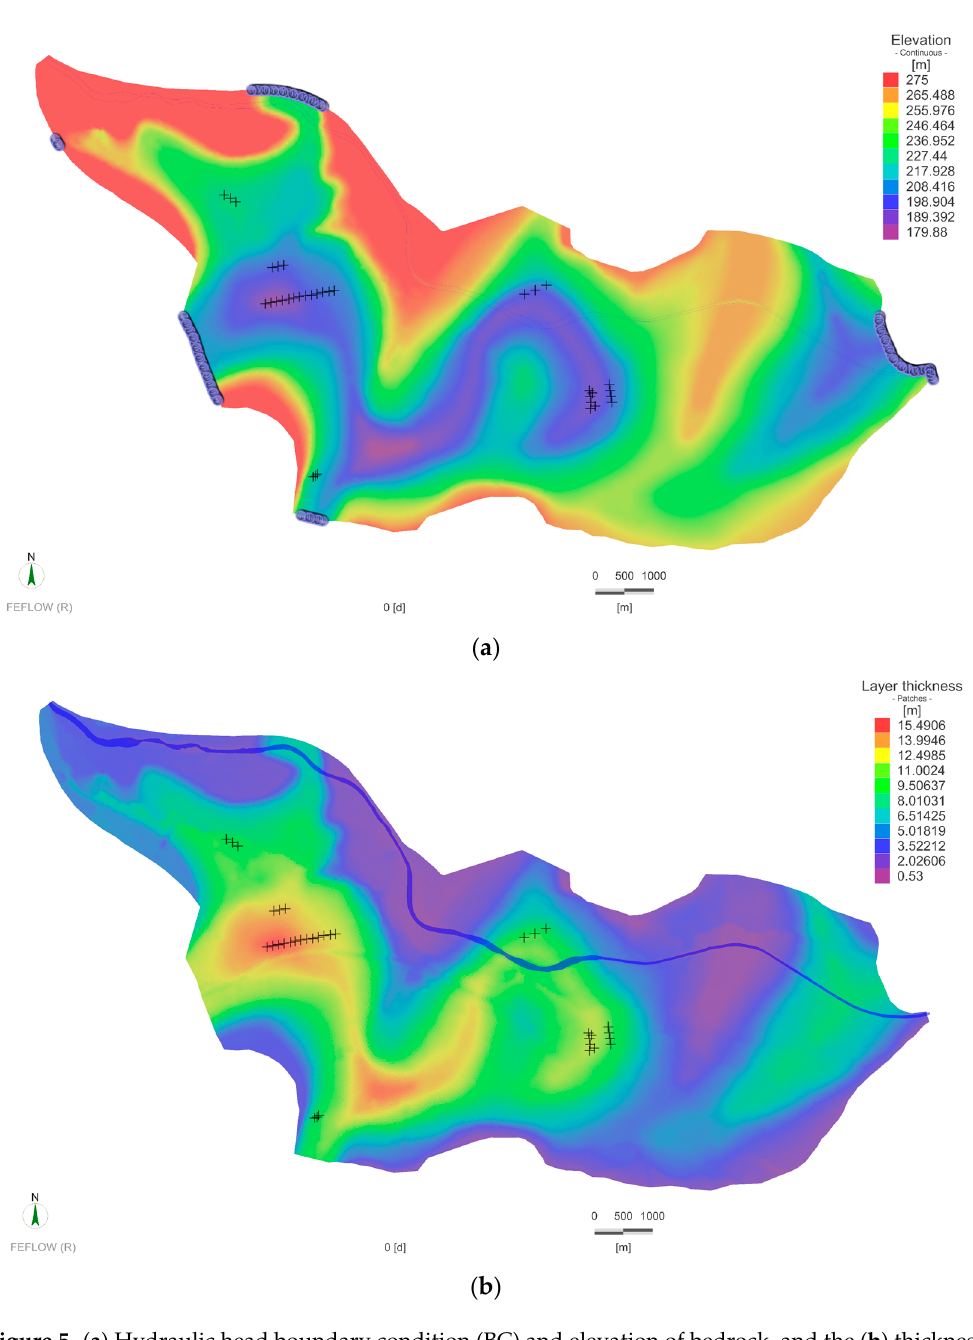
Figure 5. ( a ) Hydraulic head boundary condition (BC) and elevation of bedrock, and the ( b ) thickness of a sub-layer. Black crosses show locations of the Multilayer Well BC.